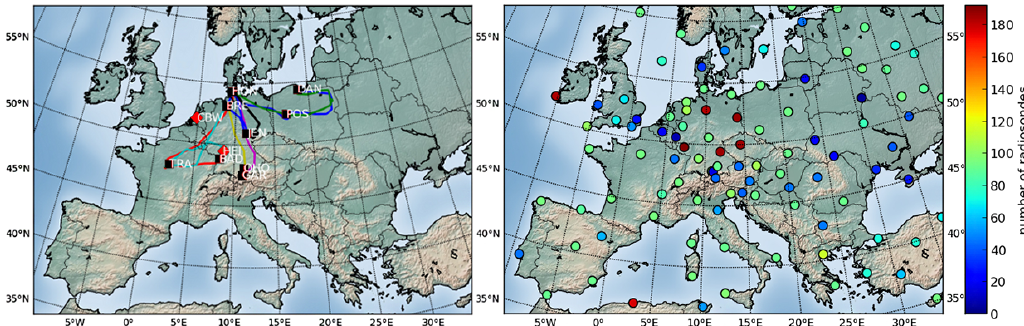
Figure 1. Maps of the simulation domain. The left map shows flight tracks of the IMECC campaign. Coloured lines indicated individual flights. Black squares mark locations of profiles from start/landing of the aircraft or spiral flights. Heidelberg (HEI) and Cabauw (CBW) ground measurement stations are also shown (red diamonds). The right map shows the positions of radiosonde launch sites (coloured circles). Circle colours indicate the number of radio soundings available in the period 24 August 2009 to 10 October 2009. Station abbreviations are shown for the additional sites: Baden-Baden (BAD), Bremen (BRE), Garmisch-Partenkirchen (GAR), Gda´nzk (DAN), Jena (JEN), Oberpfaffenhofen (OHO), Pozna´n (POS), Traînou